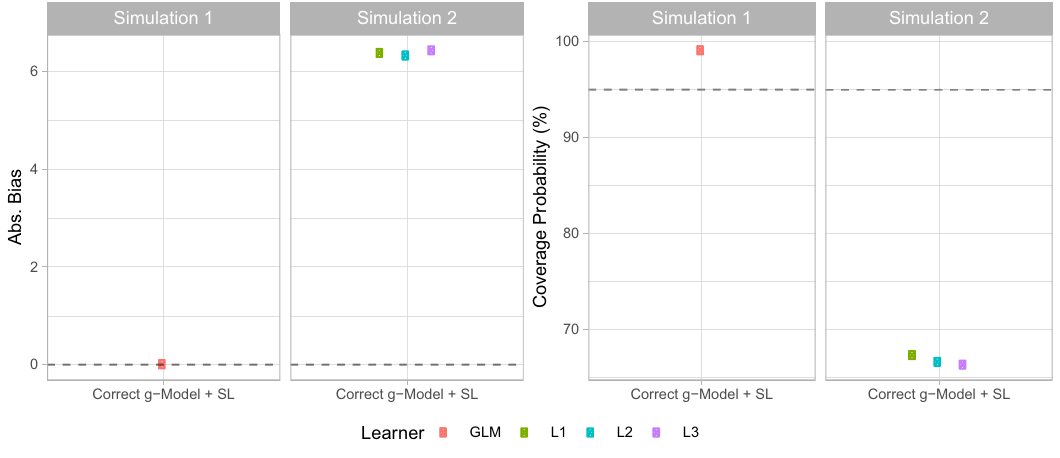
Figure 11: Absolute bias and coverage probabilities for estimation with IPTW. Bias: 0.009 ( GLM ) , 6.377 ( L1 ) , 6.325 ( L2 ) , 6.431 ( L3 ) and coverage probability: 99.1% ( GLM ) , 67.3% ( L1 ) , 66.6% ( L2 ) , 66.3% ( L3 ) .